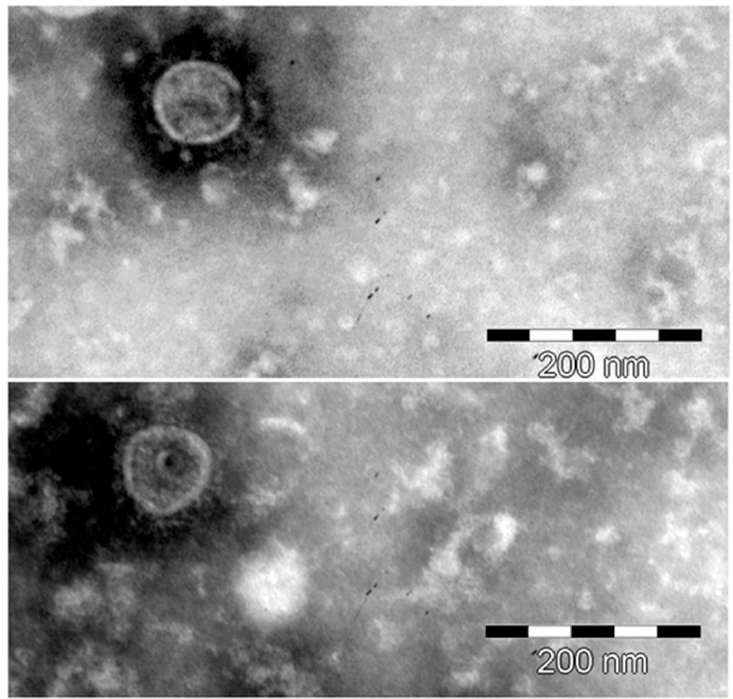
Figure 3. Negatively stained supernatant from infected Hs578T cells was analyzed by transmission electron microscopy to identify 85–95 nm virus-like particles with acentric cores and membrane spikes, comparable with MMTV and prior betaretrovirus-like particles derived from patients with PBC.